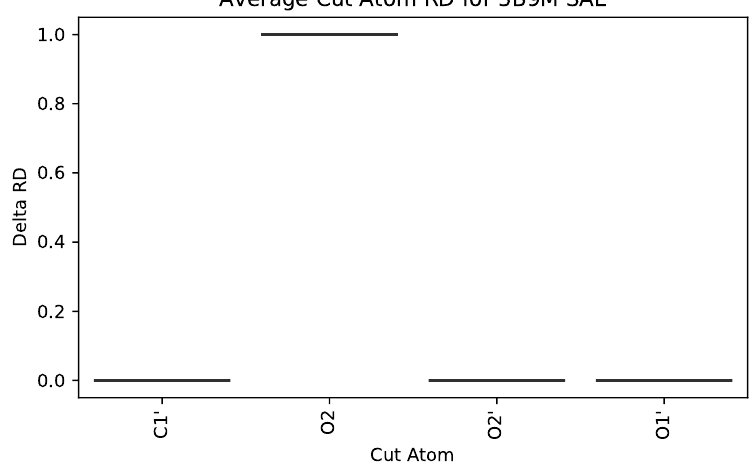
Figure 11. Box plot of SingleCut metrics for atoms in Salycylic Acid, in complex with HSA, PDB 3B9M. The flat quartile boxes designate no variance when